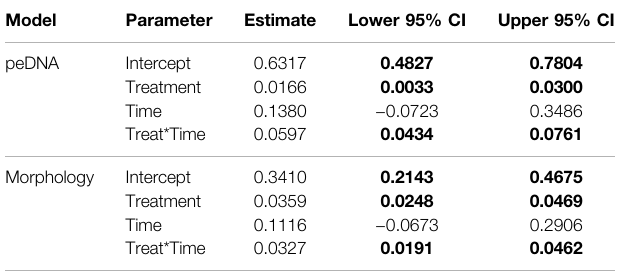
TABLE 3 | Fixed effects of linear mixed effects models of morphological and peDNA samples. Bray-Curtis dissimilarity values were dependent variables while the rotenone treatment and time and their interaction were fi xed variables. Lower and upper con fi dence limits (95% CI) for statistically signi fi cant covariates (i.e., not overlapping zero) are highlighted in